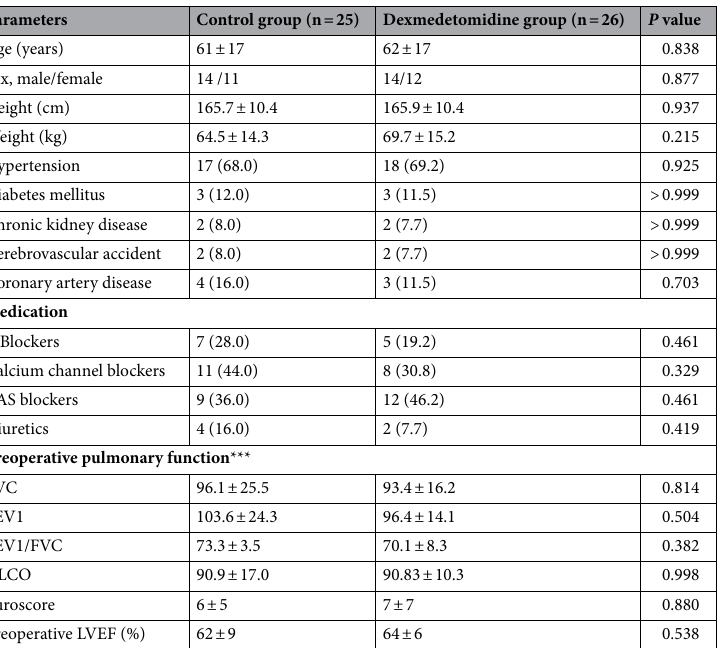
Table 1. Preoperative clinical characteristics. Values are shown as the number of patients, mean ± standard deviation. DLCO carbon monoxide diffusion capacity, FEV1 forced expiratory volume in one second,